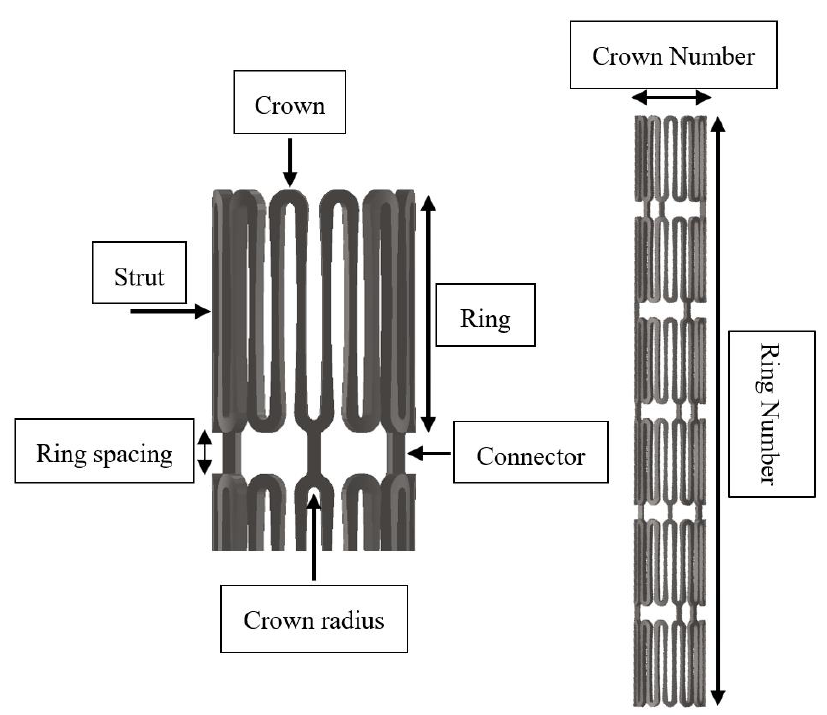
Figure 2. Illustration of important design parameters of an intravascular stent.